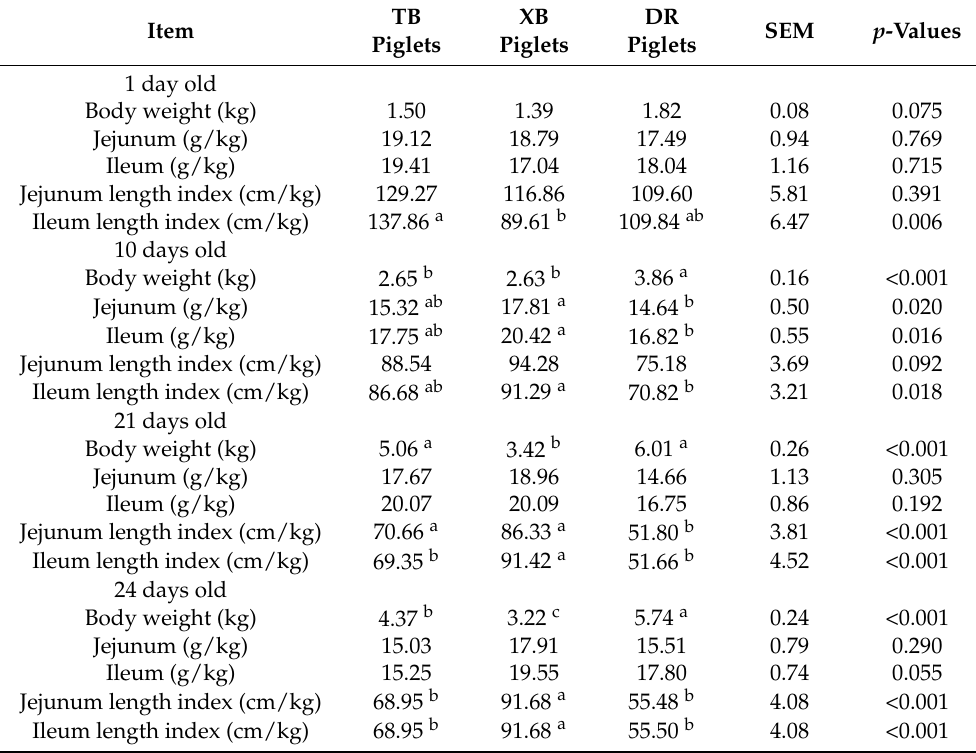
Table 1. Differences in body weight and intestinal indexes of piglets at different ages.